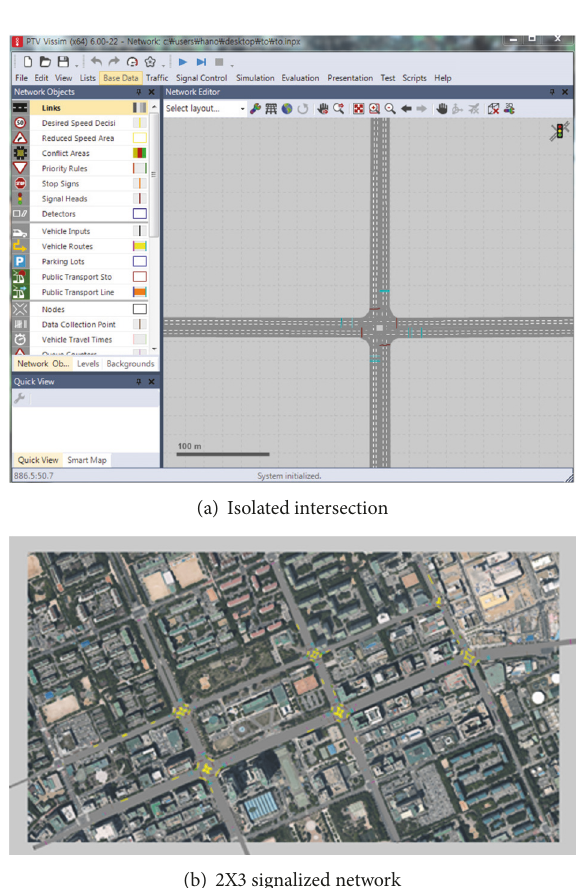
Figure 4: Simulation